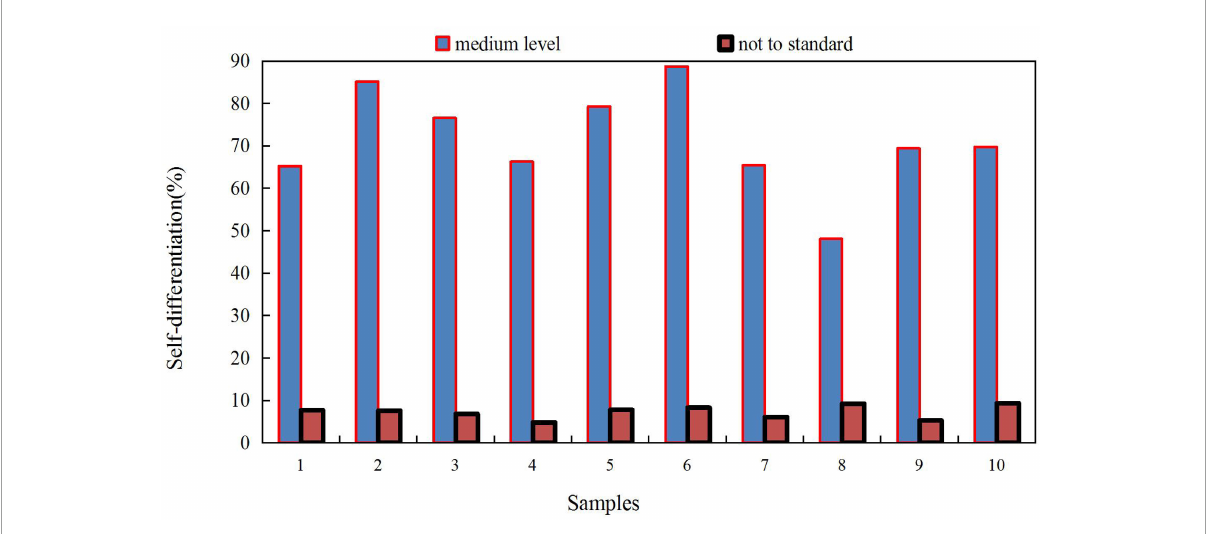
FIGURE3 Basic situation of college students’